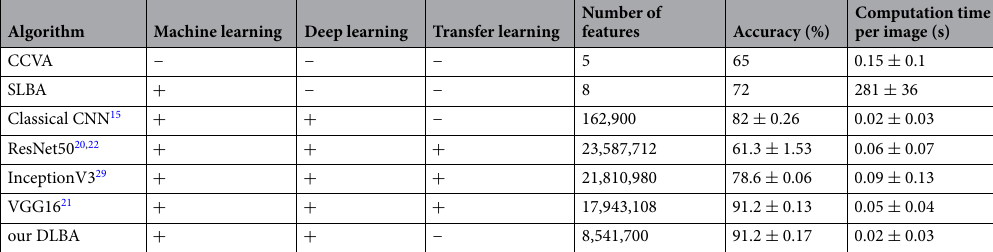
Table 1. Comparison of CCVA, SLBA, our optimized DLBA and other publicly available CNNs. For the CNNs, we show the mean accuracy ± standard deviation after three model trainings. The mean of computation time per image is given in seconds ± standard